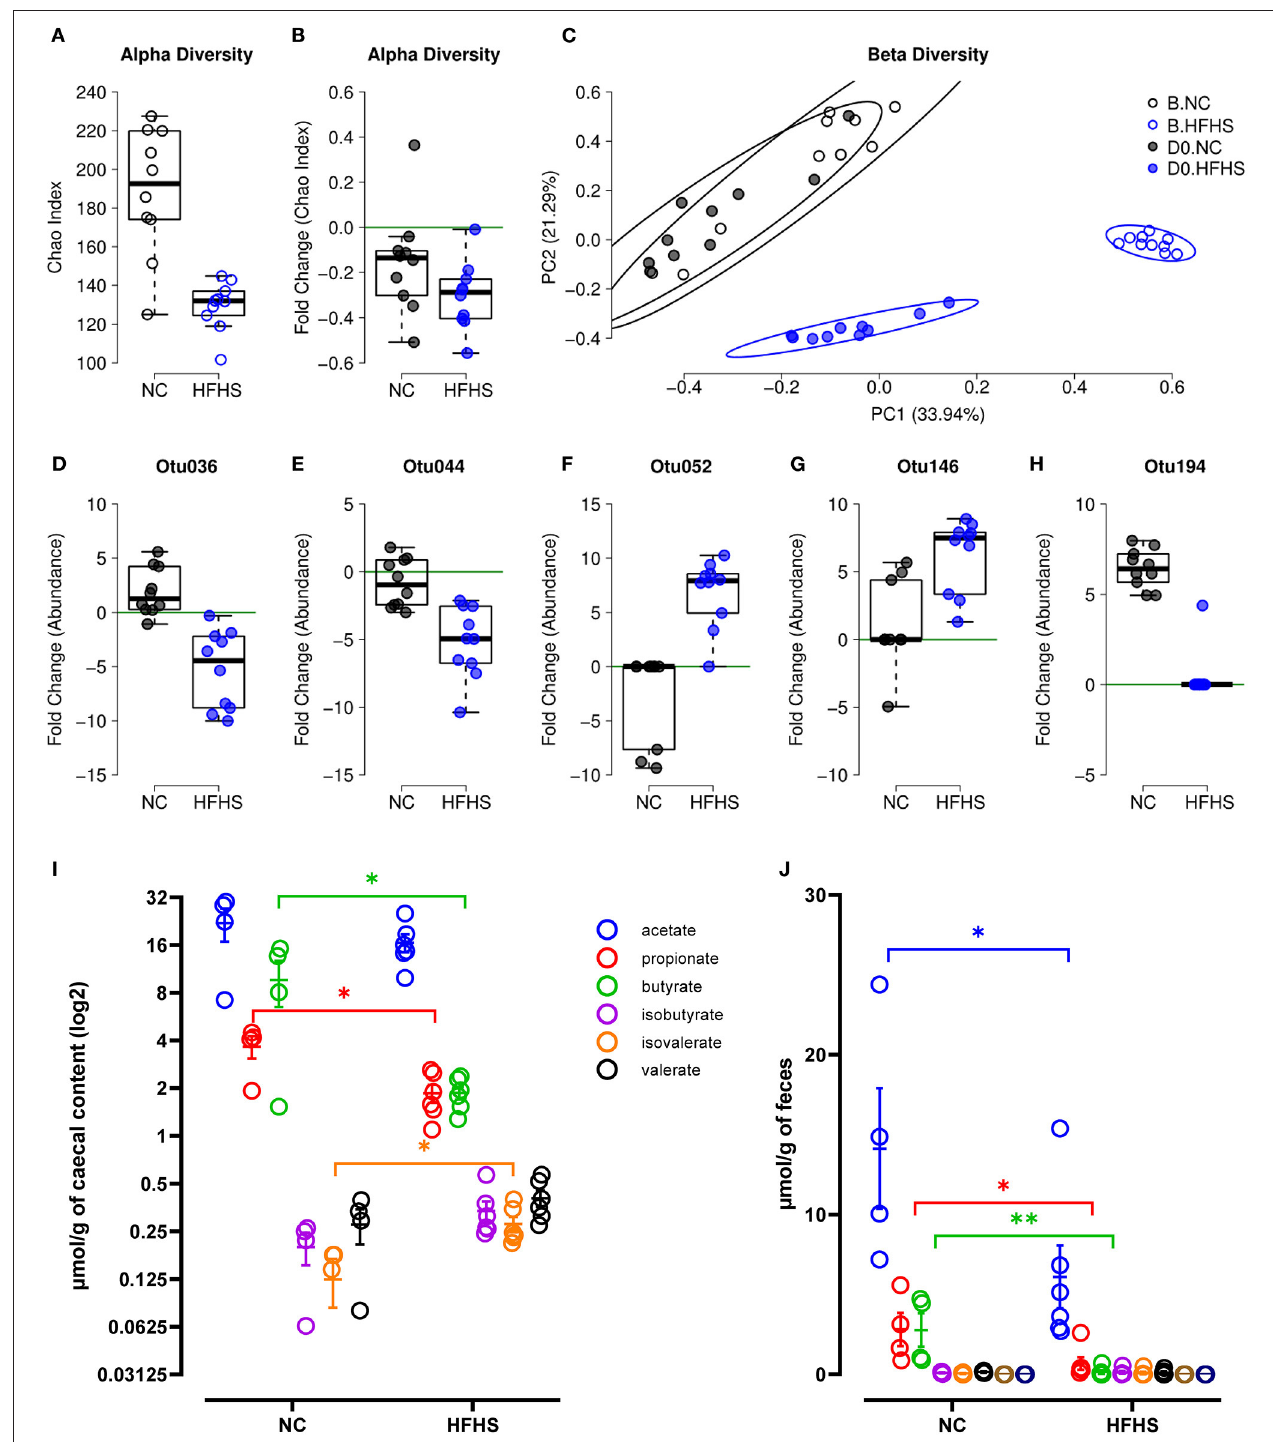
FIGURE 4 | High-fat high-sucrose diet induces gut microbiota dysbiosis. (A) α -diversity measured by Chao index at baseline B for mice fed with normal chow (NC, N = 10) vs. high-fat high-sucrose diet (HFHS, N = 9). (B) Evolution of species richness measured by a fold change of Chao index at D0 relative to B. (C) PCoA of Bray-Curtis β -diversity index showing no NC-fed vs. HFHS-fed mice, at B and at D0. (D–H) Fold change of indicator OTU’s abundances at D0 relative to B. (I, J) Short Chain Fatty Acids concentrations in µ mol/g of caecal content or feces of NC-fed or HFHS-fed mice. Means + /– SEM are plotted. * p < 0.05, ** p < 0.01 by ANOVA for parametric data or Kruskal-Wallis if not when more than 2 groups are compared, Mann-Whitney test or t -test for 2 groups comparison.